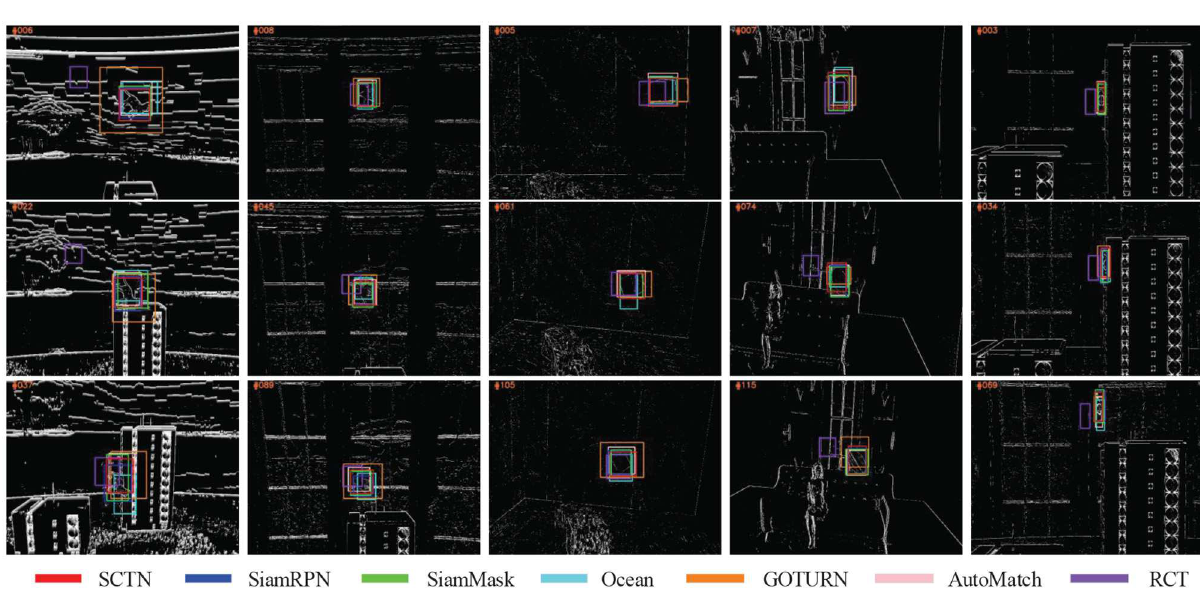
FIGURE6 Qualitative results on the five event-based test sequences from DVSOT21 dataset, where the bounding box with red, blue, green, cayn, orange, pink and purple color represent SCTN, SiamRPN, SiamMask, Ocean, GOTURN, AutoMatch and RCT respectively. From left to right, the corresponding sequences are city _ cat , city _ bottle , city _ star , sky _ cube and woman _ ball